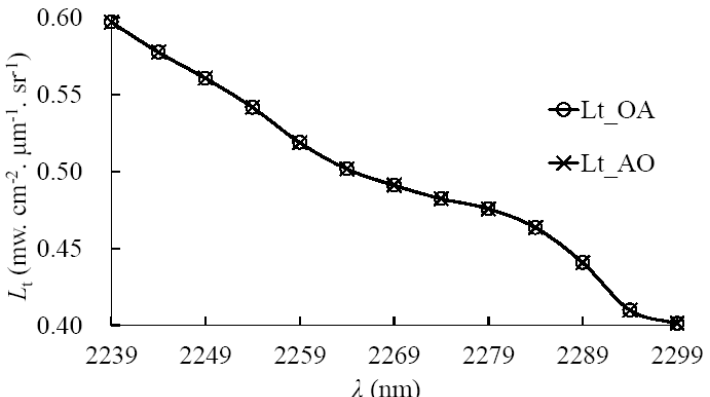
Figure 13. L t_OA derived by averaging L t simulated over each subpixel (a total of 160 × 160 subpixels), see text for description. L t_AO simulated using the average albedo of the 160 × 160 subpixels. GOSAT pixel noted above. In situ profile (i.e., k = 1, Figure 3) was used for calculating L t_OA and L t_AO .